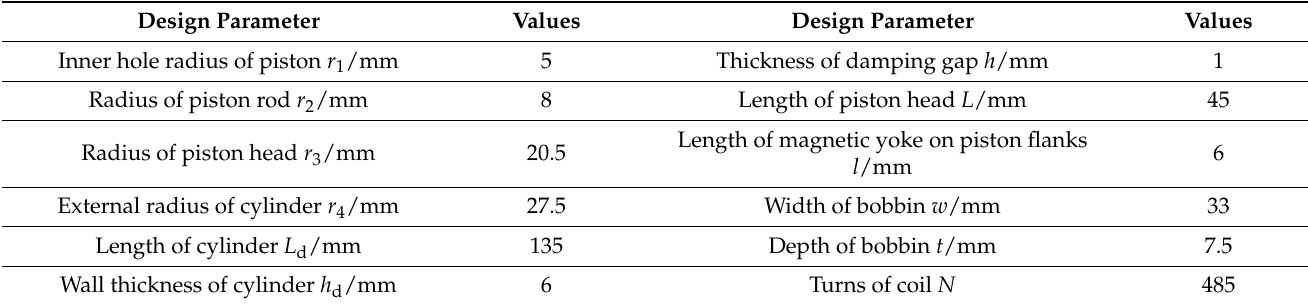
Table 1. Key structural parameters of MR damper.